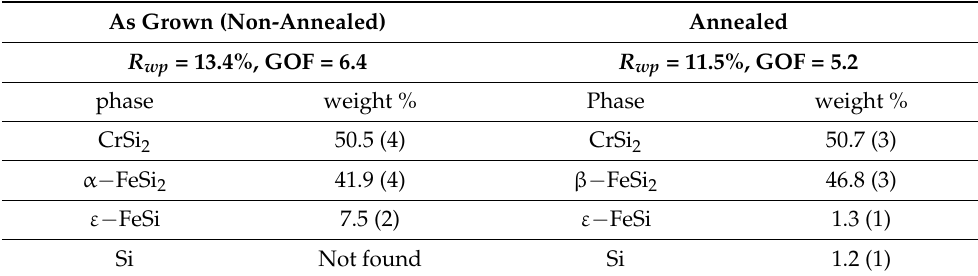
Table 2. Phase composition of the samples according to the Rietveld refinement. As Grown (Non-Annealed) Annealed R wp = 13.4%, GOF =